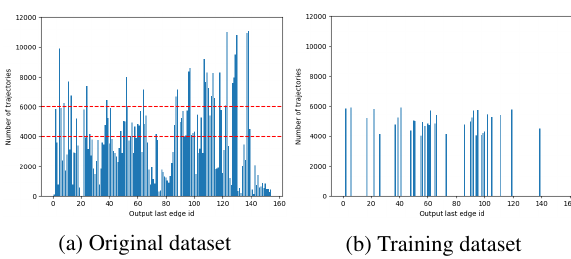
Figure 10. Number of trajectories with different output edge id in original and training dataset.